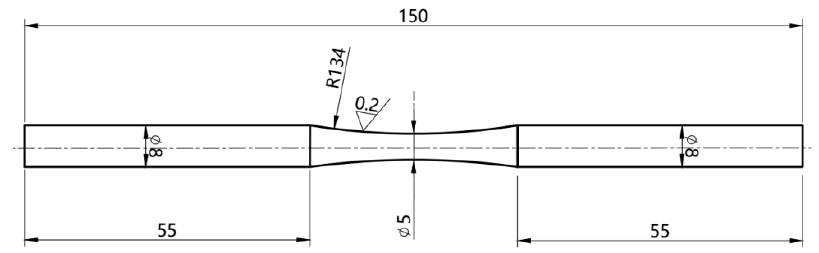
Figure 2. Schematic illustration of fatigue specimen (all units in mm).